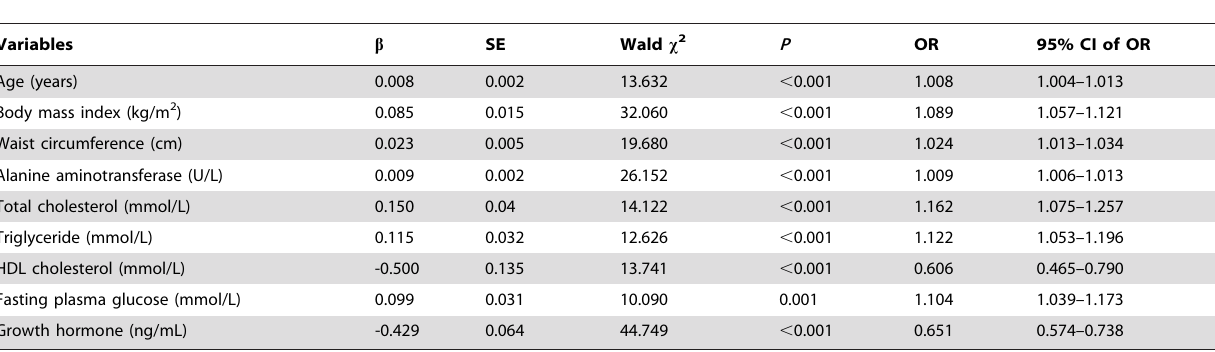
Table 3. Stepwise logistic regression analysis using NAFLD as dependent variable.